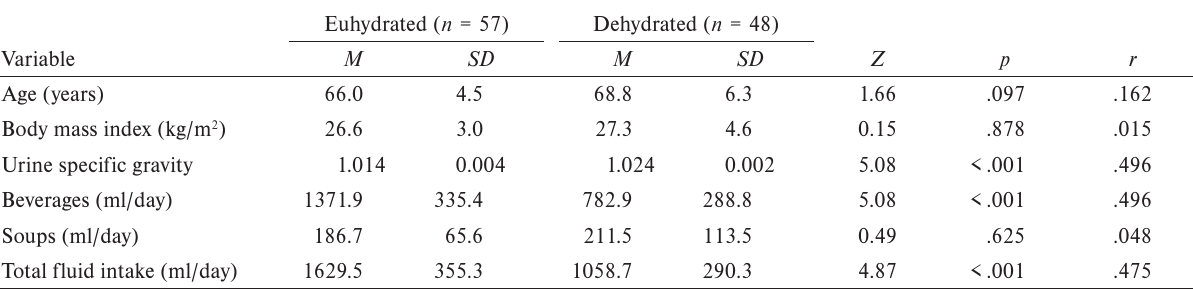
Euhydrated ( n = 57)